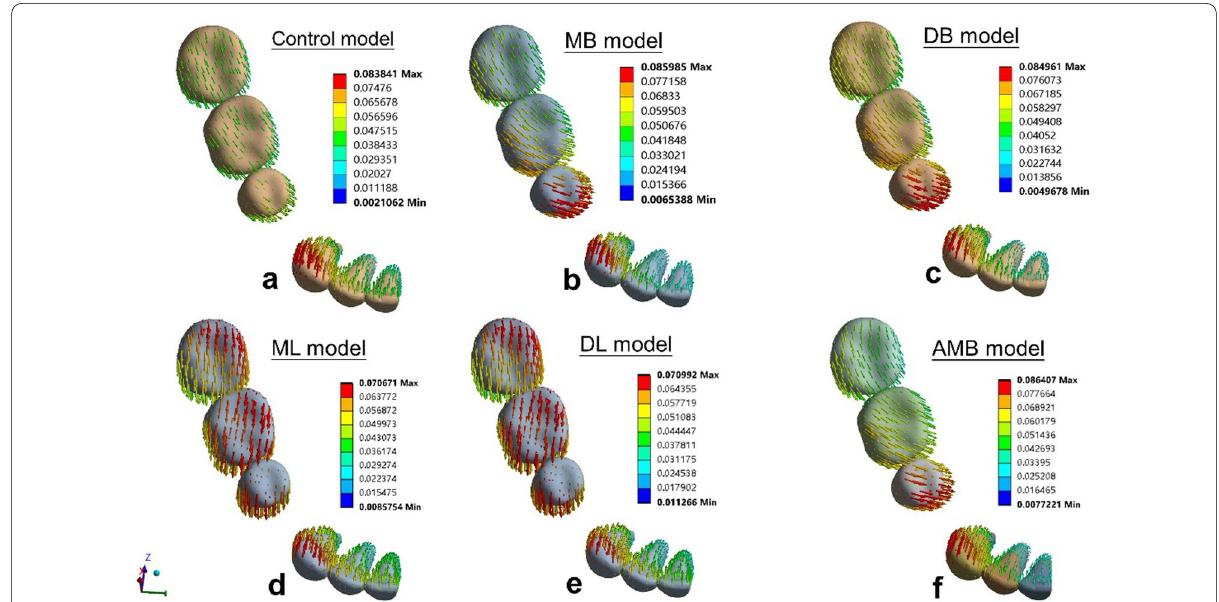
Fig. 6 Displacement tendencies of the six models in the occlusal view. a The control model, b the MB model, c the DB model, d the MLmodel, e the DLmodel, and f the AMB